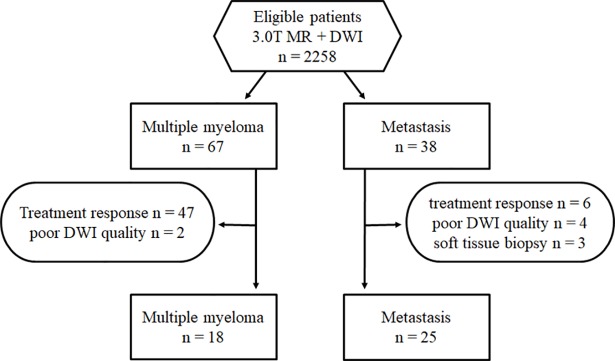
Flow diagram of the study.